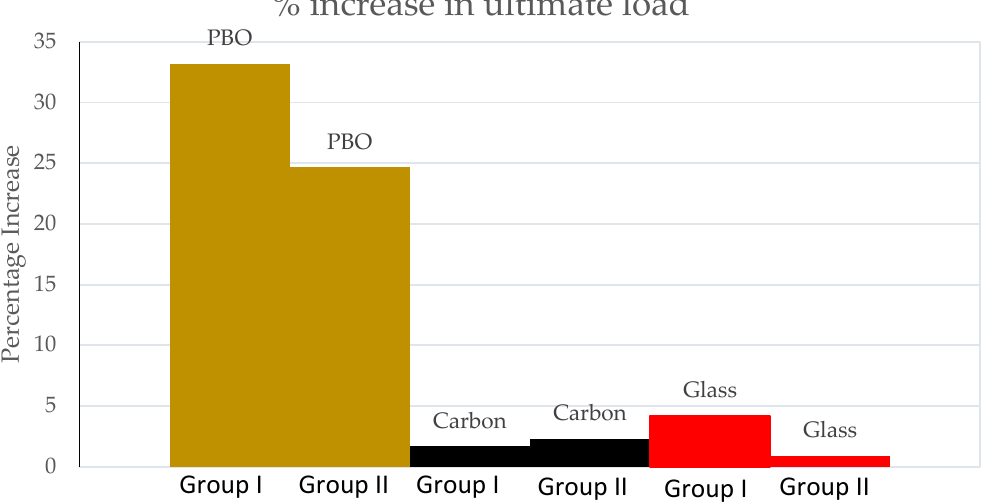
Figure 15. Comparisons of the percentage increase in ultimate load.